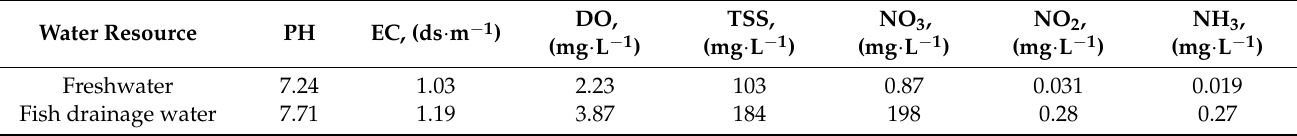
Table 2. Chemical analysis of freshwater and fish drainage